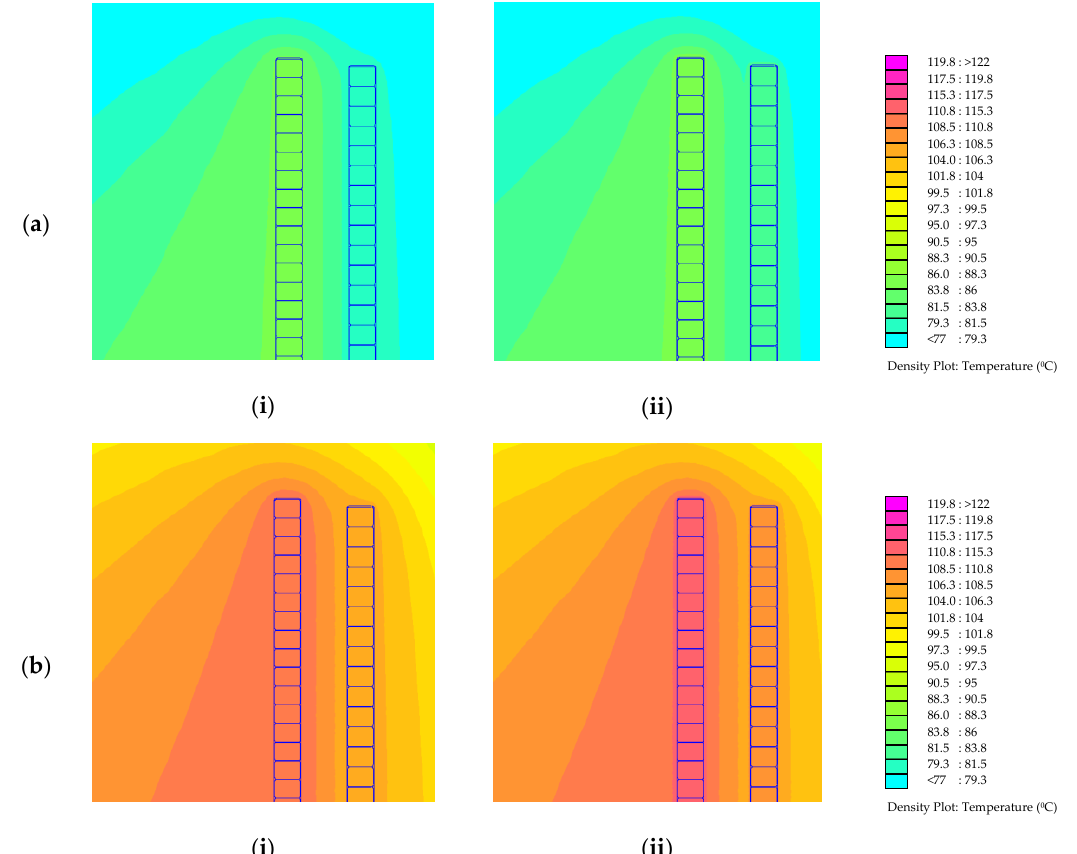
Figure 20. Results from the thermal analysis. ( a ) Without including the effect of solar irradiance; ( b ) including the effect of solar irradiance; ( i ) initial state; ( ii ) state at 293.5 s